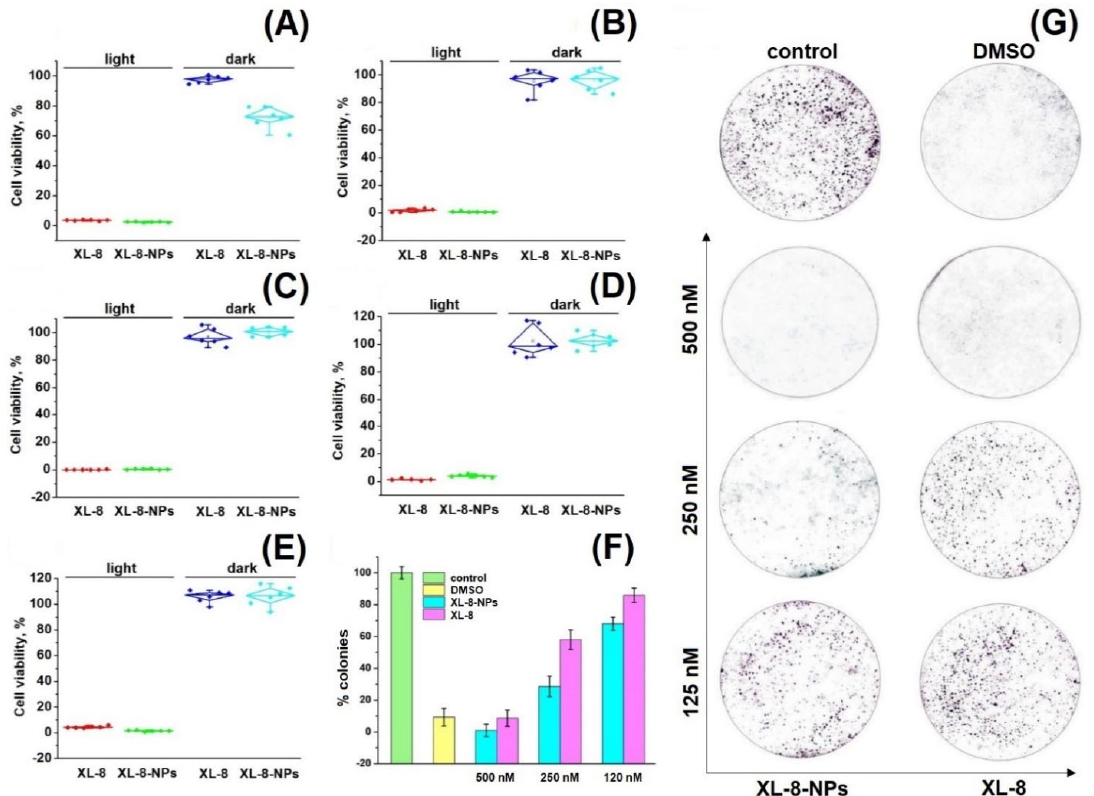
Figure 3. Photo- and cytotoxicity of XL-8 (500 nM) and XL-8-NPs (500 nM) analyzed by MTT assay. The percentage of cell Figure 3. Photo ‐ and cytotoxicity of XL ‐ 8 (500 nM) and XL ‐ 8 ‐ NPs (500 nM) analyzed by MTT assay. The percentage of cell viability was determined relative to viable control cells. SK ‐ OV ‐ 3 cells ( A ), A549 cells ( B ), HeLa cells ( C ), MCF7 cells ( D ), viability was determined relative to viable control cells. SK-OV-3 cells ( A ), A549 cells ( B ), HeLa cells ( C ), MCF7 cells ( D ), and 4T1 cells ( E ) measured at 72 h after treatment. The quantification of colony formation rate in HeLa cells after treatment with 10% DMSO and XL-8- or XL-8-NPs-based PDT ( F ). Giemsa-stained plates of colony formation assay carried out on HeLa cells ( G